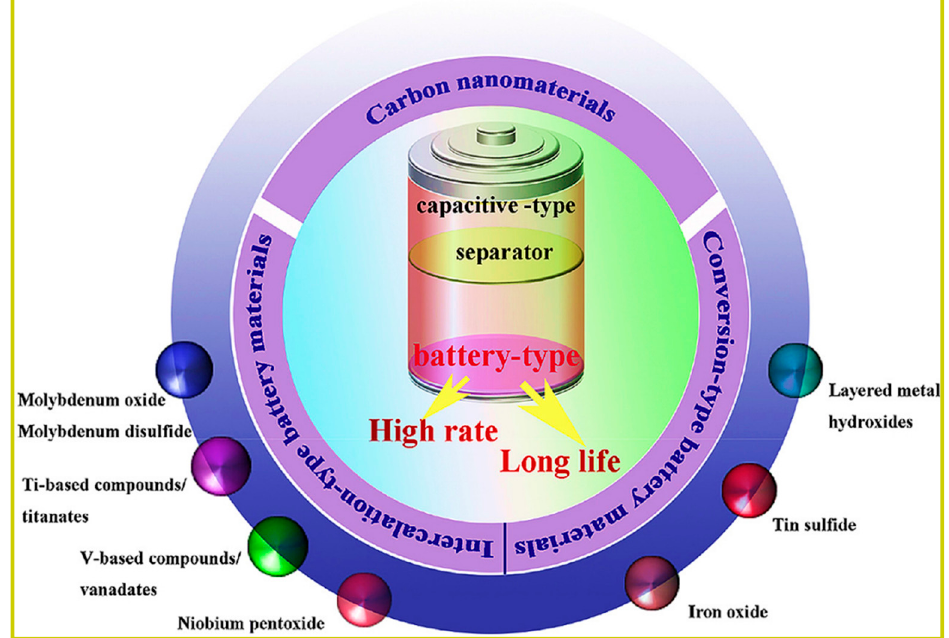
Figure 13. The graphical representation of the battery-type materials according to two electrochemical reaction mechanisms (intercalation and conversion-type battery), utilized in HSCs. Reprinted with permission from [199], Copyright 2020, Elsevier.